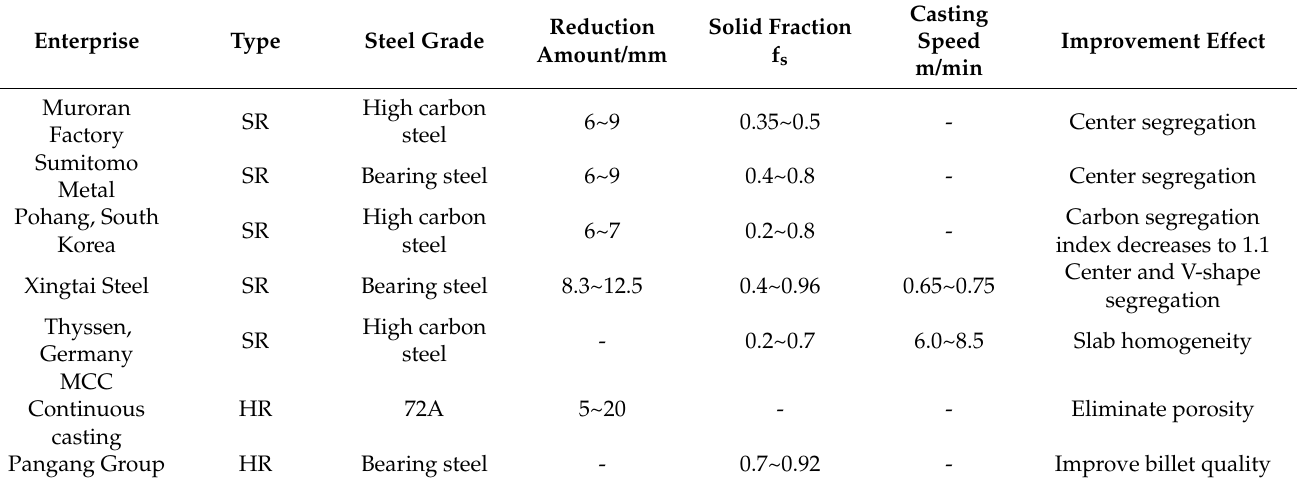
Table 6. Application of reduction technology in industry